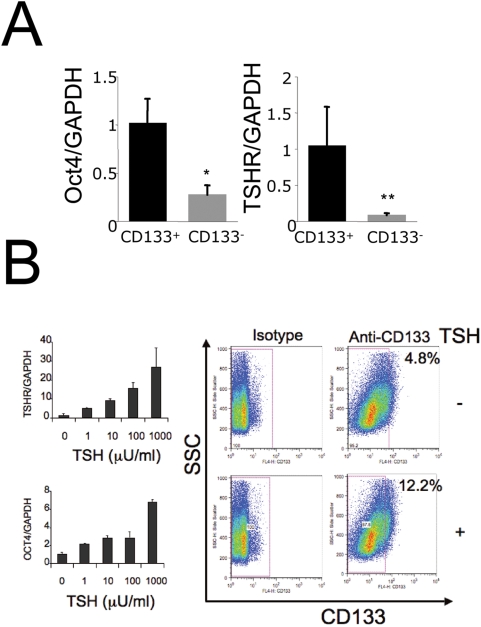
CD133+ cells express high levels of Oct4 and TSHR genes.(A) qRT-PCR analysis indicates that CD133+ cells express higher levels of Oct-4 and TSHR than do CD133− cells. Results are shown as mean and s.e.m. Asterisk: P<0.05; two asterisks: P<0.01. (B) TSH upregulates the expression of TSHR and Oct4 and increases the number of CD133+ cells. Left panel: human recombinant TSH elicits a dose-dependent upregulation of TSHR and Oct4 mRNA levels in unsorted ARO cells. Right panel: the number of CD133+ cells increases three-fold in response to TSH stimulation.